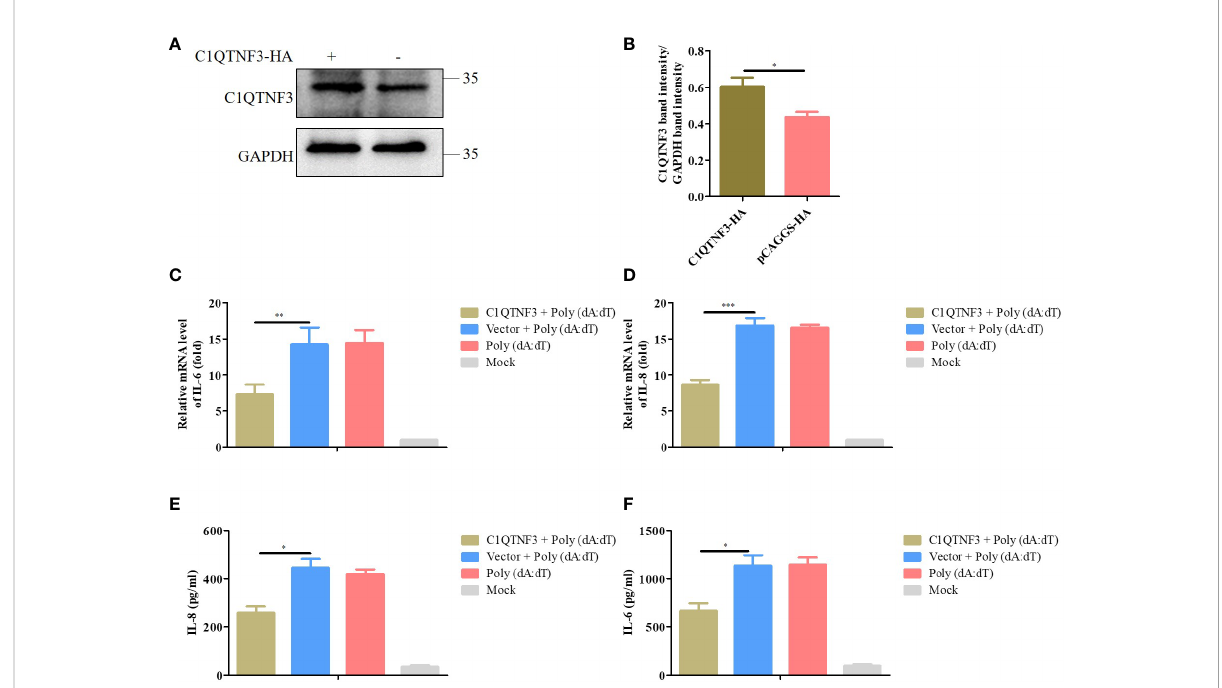
FIGURE 7 Overexpression C1QTNF3 inhibits poly (dA:dT)-induced in fl ammatory cytokine production in PK-15 cells. (A, B) Overexpression of HA-tagged C1QTNF3 proteins was detected using western blot analysis. The mRNA levels of (C) IL-6 and (D) IL-8 in PK-15 cells with C1QTNF3 overexpression for 24 h followed by poly (dA:dT) stimulation for 48 h. The GAPDH gene was used as the internal control for normalization. The 2 - DD Ct method was used to analyze the results of qPCR. The protein levels of (E) IL-8 and (F) IL-6 in PK-15 cells with C1QTNF3 overexpression for 24 h followed by poly (dA:dT) stimulation for 48 h p <0.05 (*), p < 0.01 (**), and p < 0.001